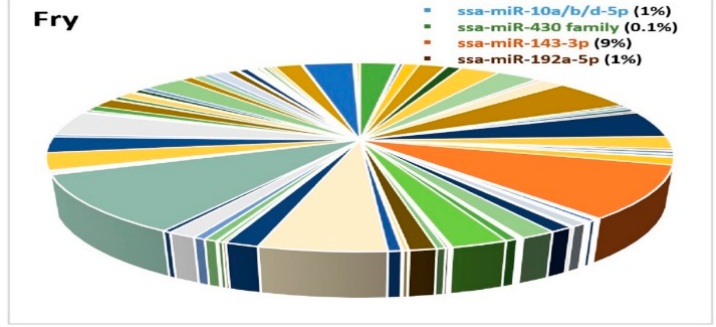
Figure 8. A pie chart demonstrating the miRNA expression diversity (511 miRNAs) in fry. The ssa-miR-10a/b/d-5p family, the miR-430 family, ssa-miR-143-3p and ssa-miR-192a-5p are shown in blue, green, orange and brown colors, respectively, in Figure 8.